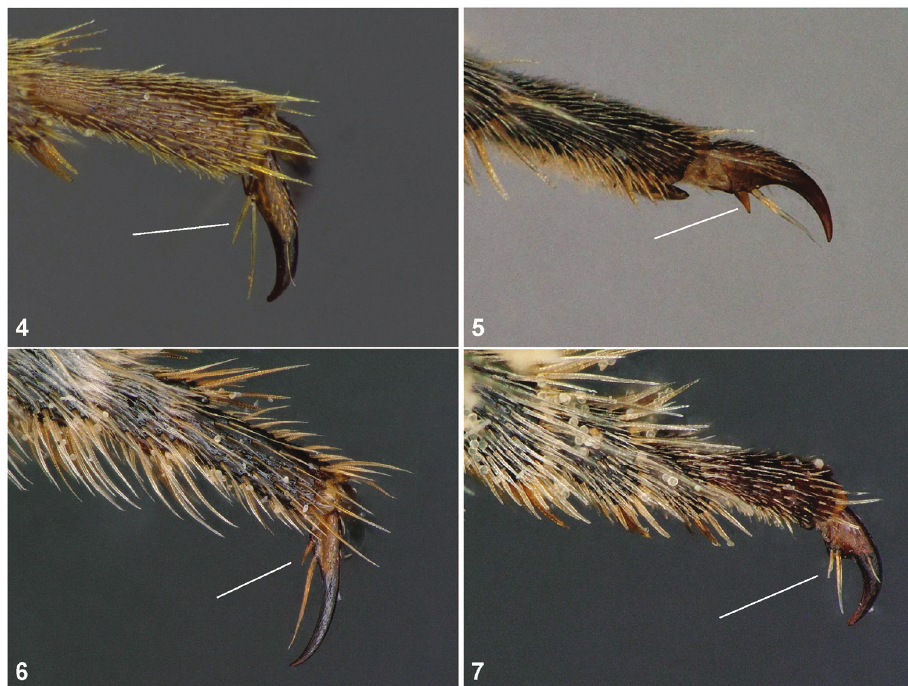
Figures 4–7. Claw of hind leg of females; the white lines show the basal seta; the seta is considered elon- gate in 4, 6 and 7 and modified to a thick process in 5 . 4 Megachile ( Pseudomegachile ) ericetorum 5 M. ( Eutricharaea ) deceptoria 6 M. ( Eurymella ) patellimana 7 M. ( Anodonteutricharaea ) thevestensis